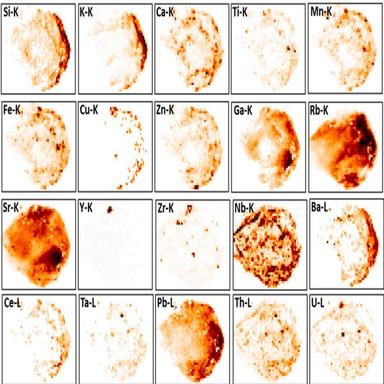
μ-XRF elemental maps of a soil particle from the Søve site, showing presence of both Th and U. Map size 2650 � 2000 μm2 , stepsize 50 μm, 1 s per pixel.